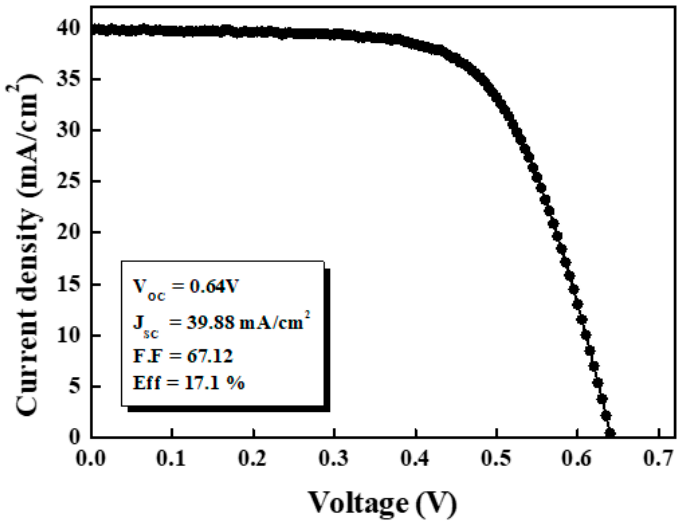
Figure 6. The J-V curves of the CIGSSe solar cell with an ALD-grown Zn(O,S) buffer layer. Process